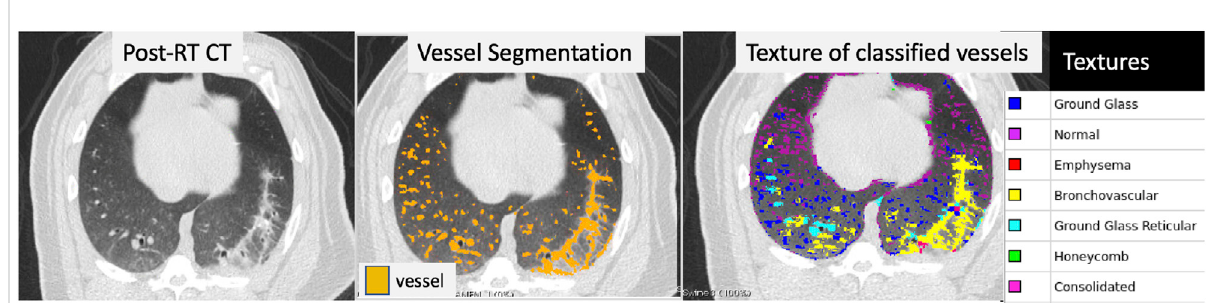
FIGURE 2 Example of a post-RT CT scan showing radiographic damage (left frame), the resulting vessel segmentation (middle frame), and the texture classi fi cationforeachvoxel(rightframe)thatwasclassi fi edasavessel.Thevesselsegmentationclassi fi esseveralvoxelsintheareaoftheCTshowing radiographic change as vessel that are likely false positives. Texture analysis was performed over the entire lung and is shown masked by the voxels that were identi fi ed as vessel in the third panel. The textures of the voxels in the region of false-positives are bronchovascular, consolidated, or ground-glass reticular which are expected radiation-induced